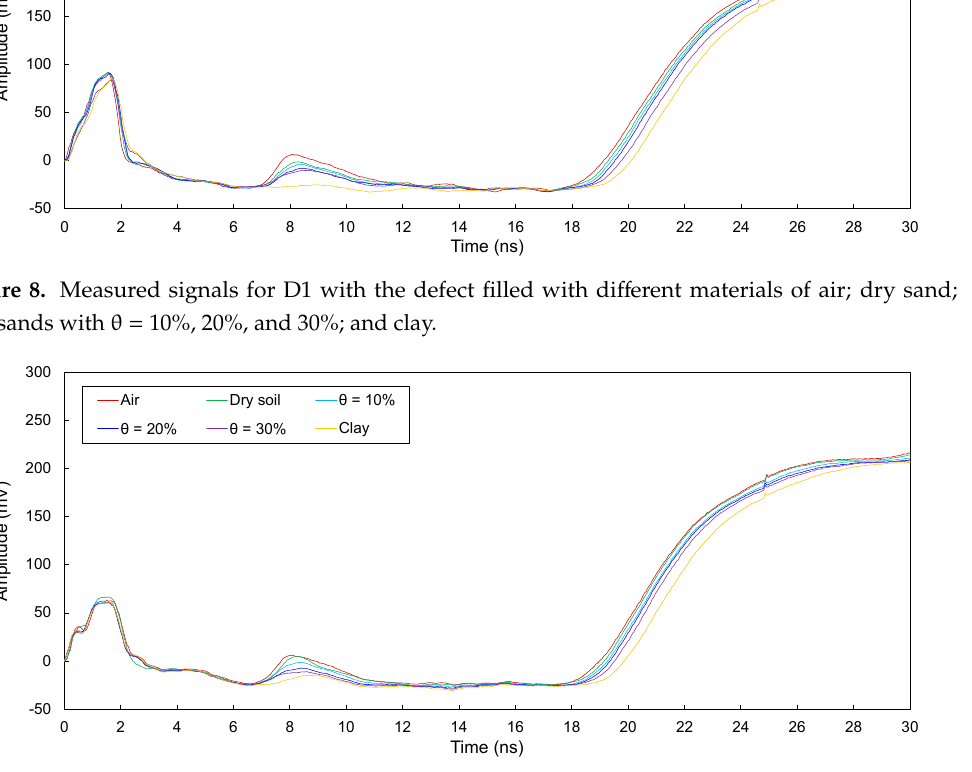
Figure 10. Measured signals for D3 with the defect filled with different materials of air; dry sand; wet sands with θ = 10%, 20%, and 30%; and clay. Figure 11. Measured signals for D4 with the defect filled with different materials of air; dry sand; wet sands with θ = 10%, 20%, and 30%; and clay.